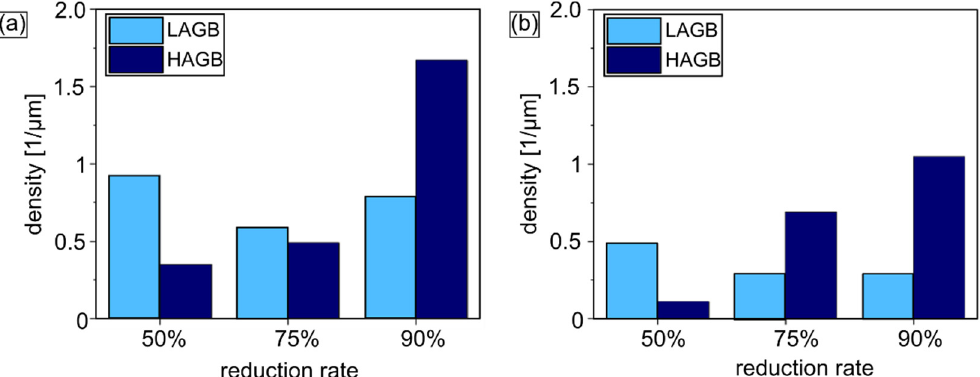
Figure 4. Density of LAGBs and HAGBs obtained for Zn-1Cu ( a ) and Zn-5Cu ( b ) alloys cold-rolled with different reduction rates.